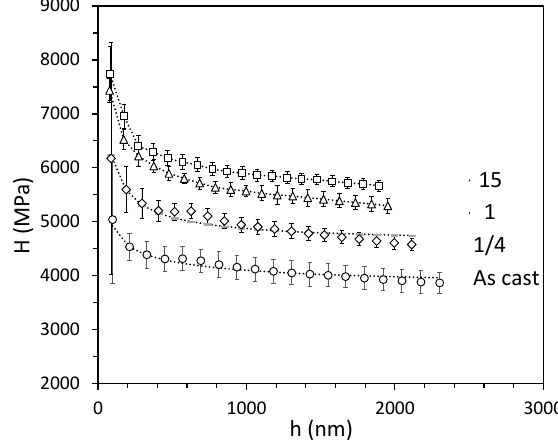
Figure 2. Indentation size effect in as cast sample and samples HPT strained to 1/4 turn, 1 turn and 15